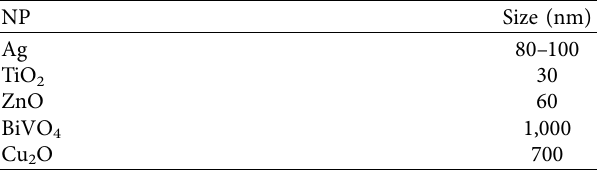
Table 1: Size of ENPs used in this